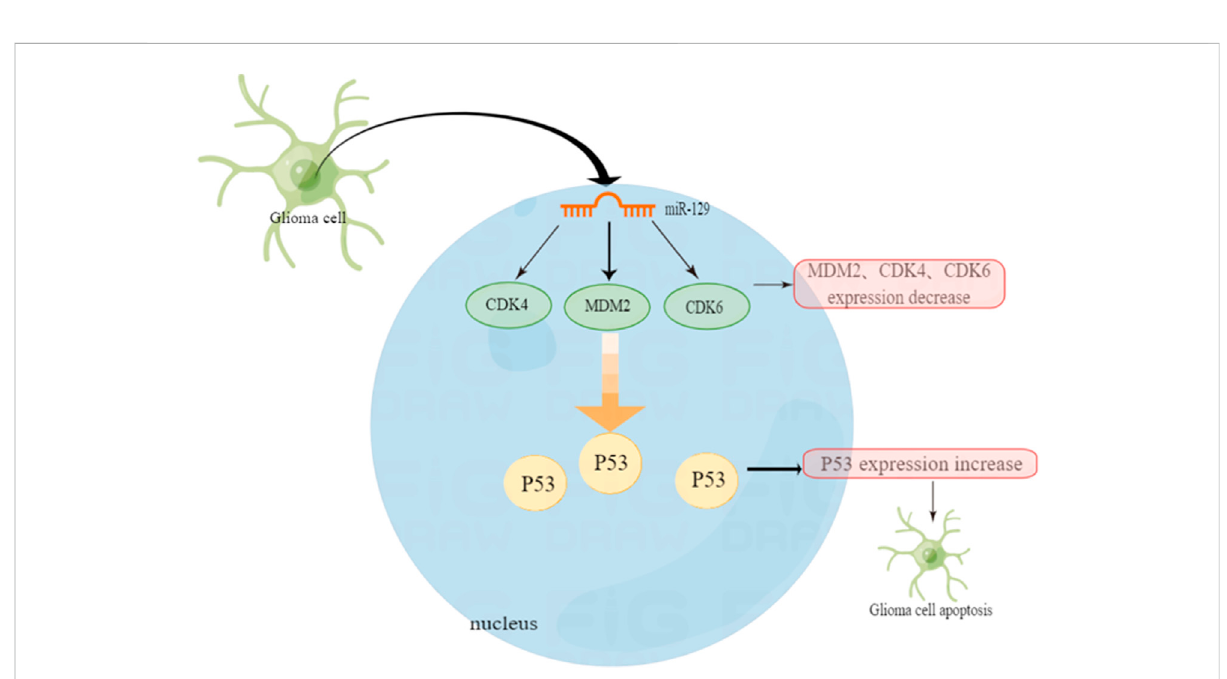
FIGURE 2 P53 function in glioblastoma and the regulation mechanism of non-coding micro